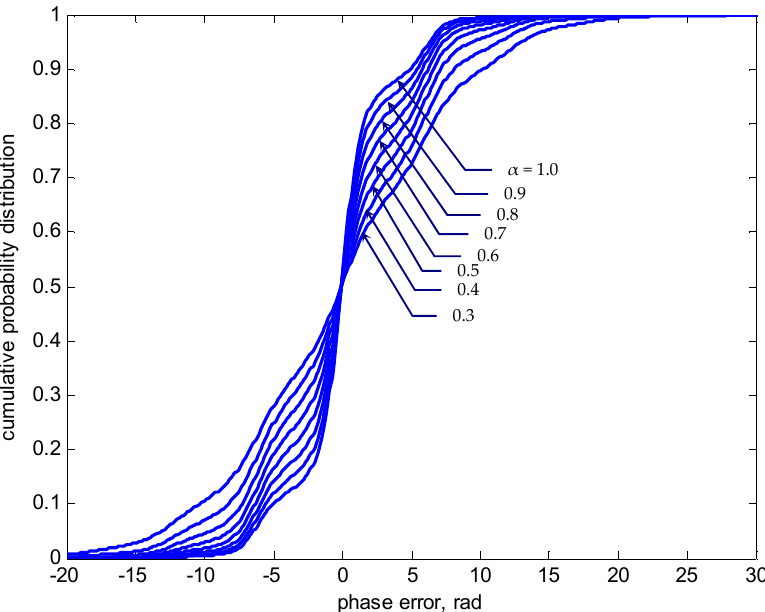
Figure 9. Nonmodulo-2 π phase-error cumulative probability distribution at τ = 10 for various SNR values ( γ = 0).